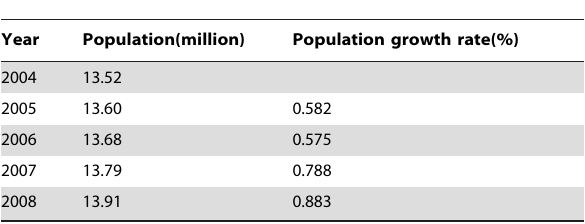
Table 1. Summary of Population in